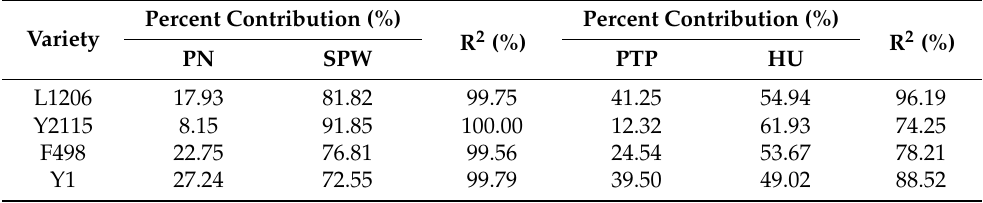
Table 6. Relative weight analysis of productive panicle number versus single panicle weight, and productive tiller percentage versus heading uniformity on grain yield in 2019 and 2020 (two-year average).